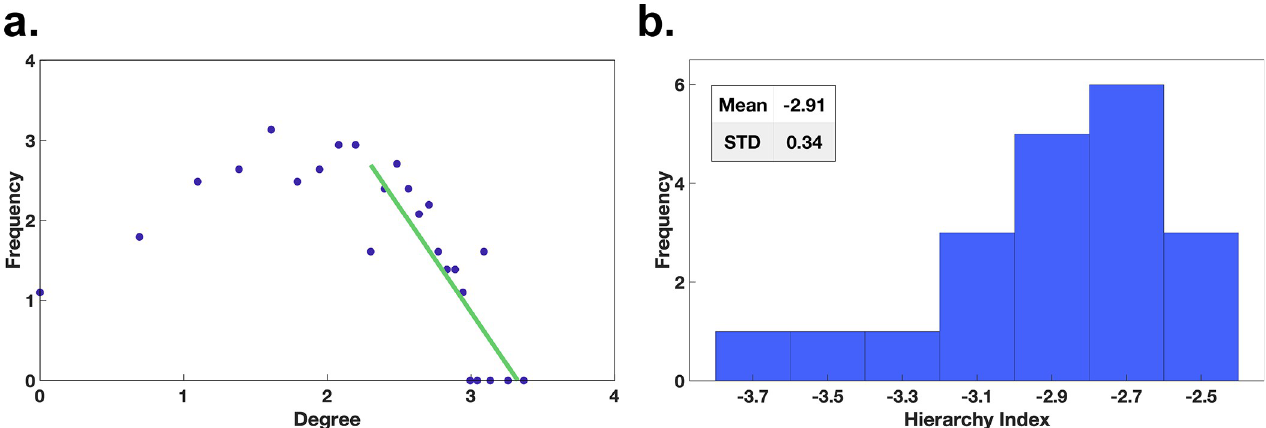
Fig 6. Hierarchy index. (a) The frequency of occurrence of the node degree for a single participant. The green line indicates the linear regression starting at the median of the distribution. (b) The distribution of the hierarchy index across all participants.